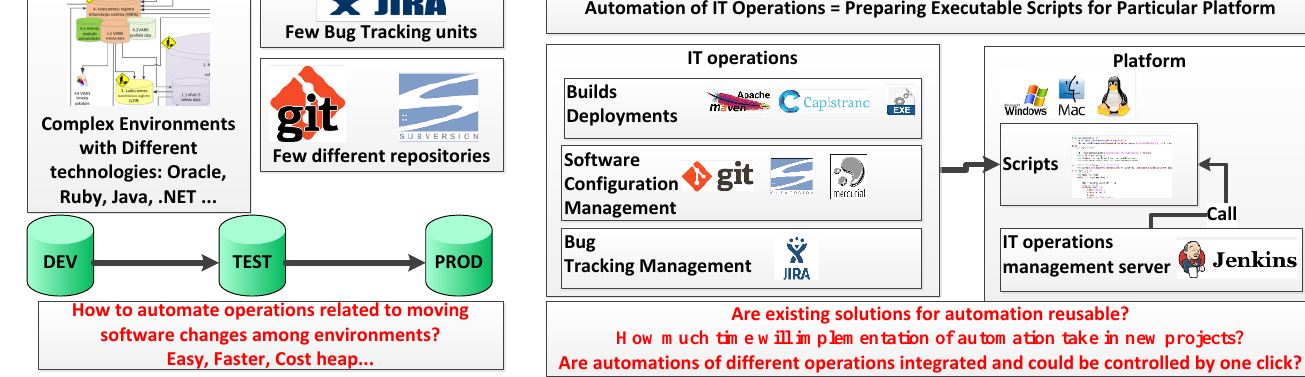
Fig. 1. The scope, definitions and problems of the